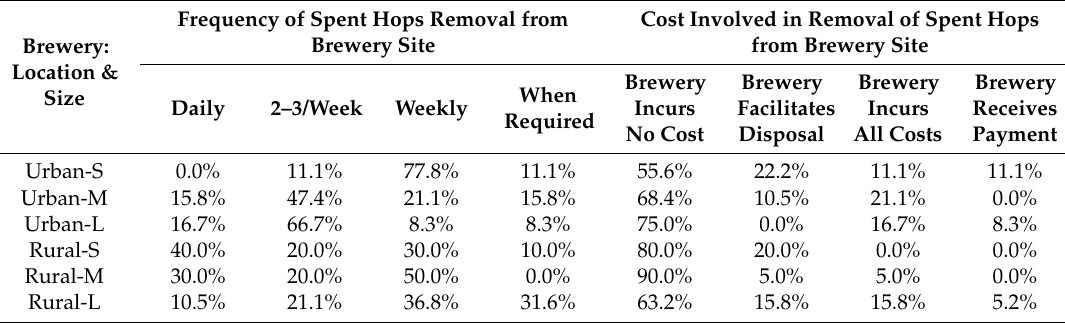
Table 3. Frequency of spent hops removal and costs incurred, by brewery location and